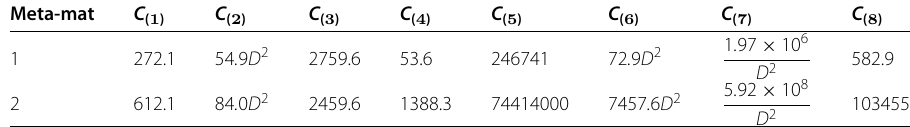
Table1 Summary of adopted parameters and information for the two metamaterials Meta-mat D a Matrix Compliant layer Stiff inclusion 2b E b 1 ρ 1c f E 0 E ∞ 2 b ρ 2c g E 3b ρ 3c h Epoxy Silicon rubber Lead d 10 6 5 1 . 175 × 10 − 4 0 . 47 × 10 − 4 1300 40.8 11600 1 21 4.35 1180 21 21 21 Mortar Natural rubber Lead e 6 0.01 30 30 2500 30